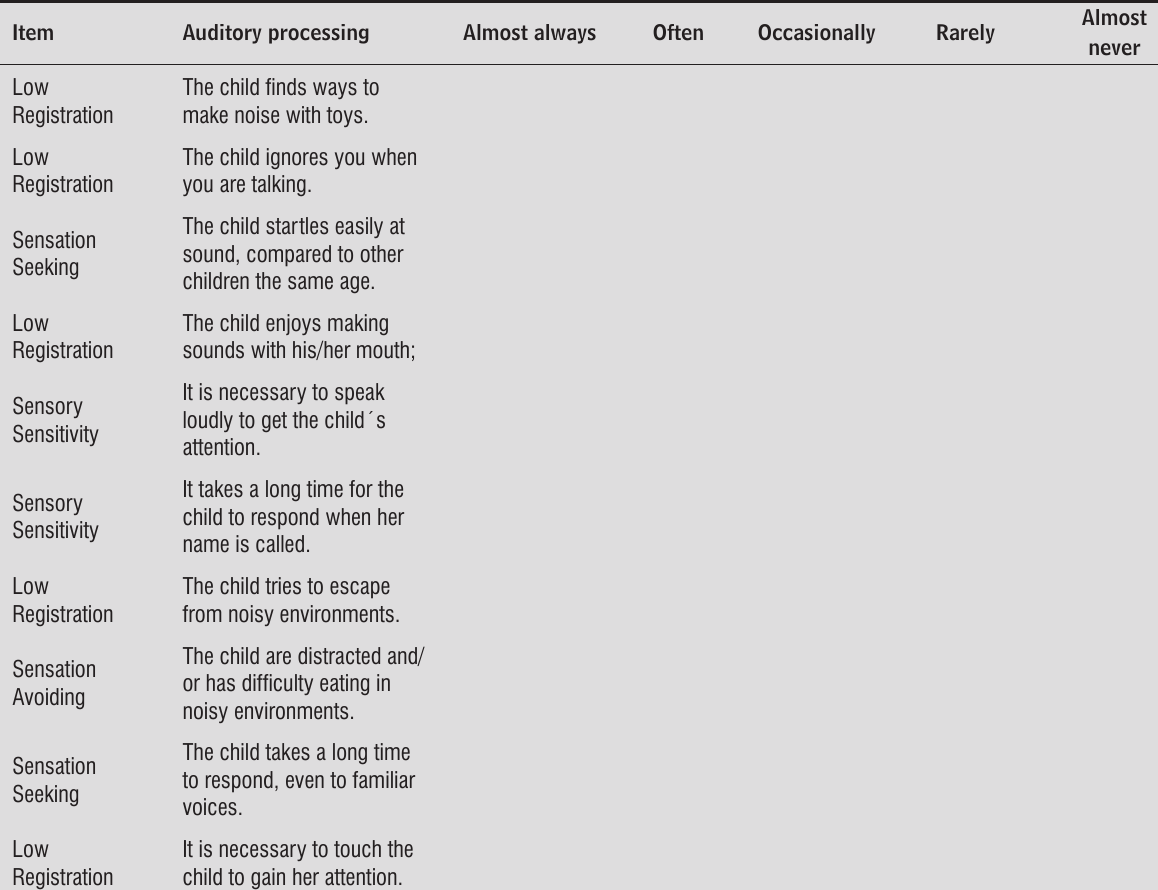
Table 1 - Part of Infant/Toddler Sensory